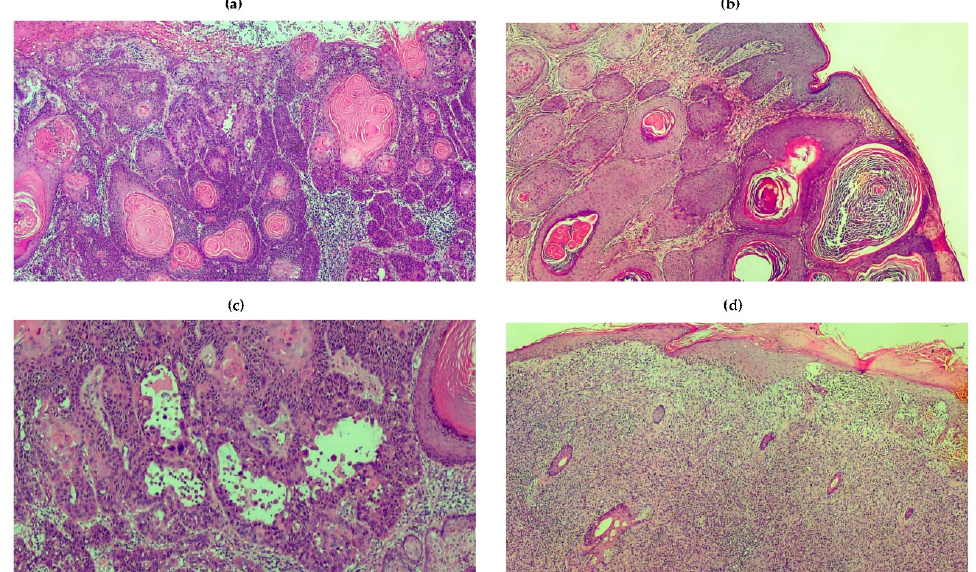
Figure 4. Histologic variants of SSC. Panels are representative of histologic patterns from patients with SCC. ( a ) A moderately differentiated and ulcerated lesion showing enlarged, hyperchromatic and irregular nuclei. Corneal pearls in the middle reflect the keratinization ability. Malignant cells are surrounded by abundant inflammatory cells. ( b ) Verrucous SCC characterized by deeply invasive properties. ( c ) Spindle cell SCC showing elongate, fusiform cells that blend with the surrounding reactive fibroblastic component. ( d ) Acantholytic SCC characterized by a pseudoghiandolar pattern and dyskeratosis of tumor cells. The acantholytic phenomenon a ff ects the inner portion of invasive nests and